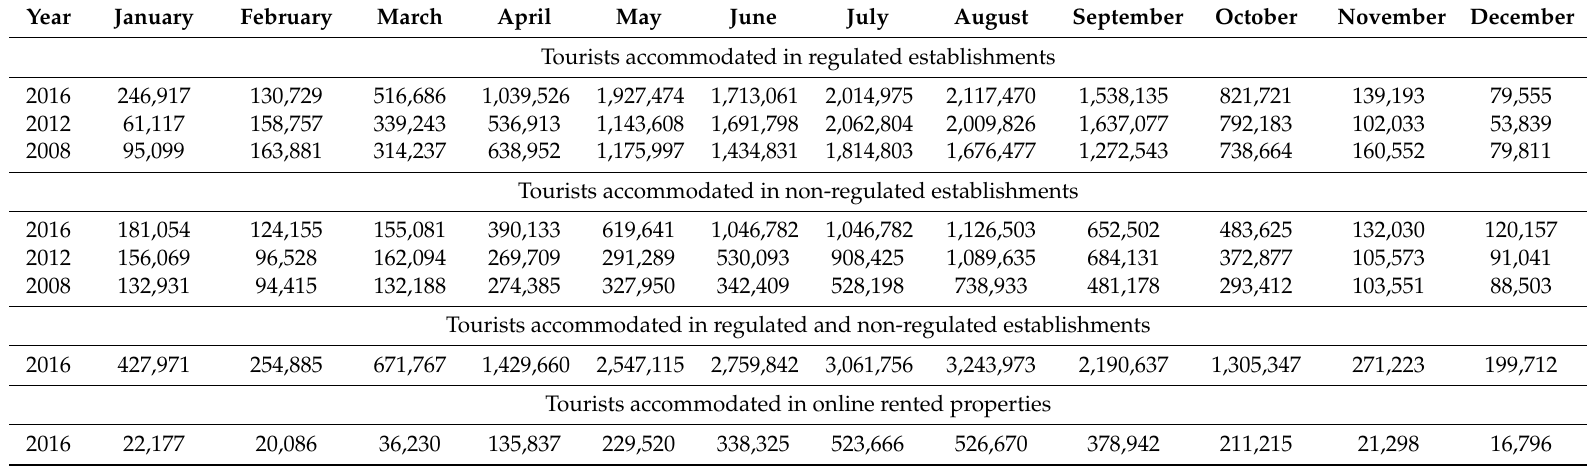
Source: Agency for Tourism of the Balearic Islands. Own